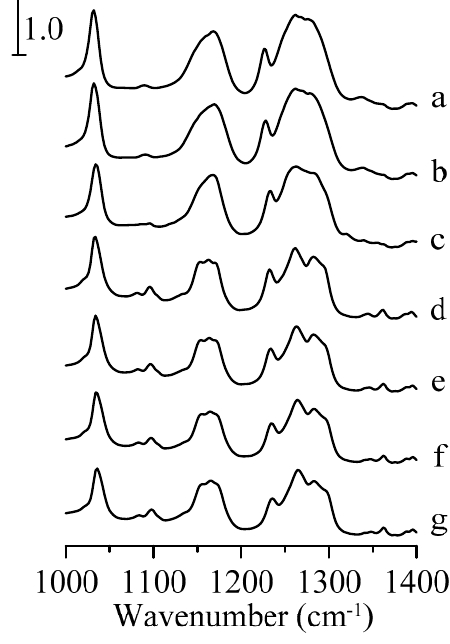
Figure 9. Infrared spectra of mica/1-ethyl-3-methylimidazolium trifluoromethanesulfonate mixture obtained under ambient pressure (curve a) and at 0.4 (curve b), 0.7 (curve c), 1.1 (curve d), 1.5 (curve e), 1.8 (curve f), and 2.5 GPa (curve g).